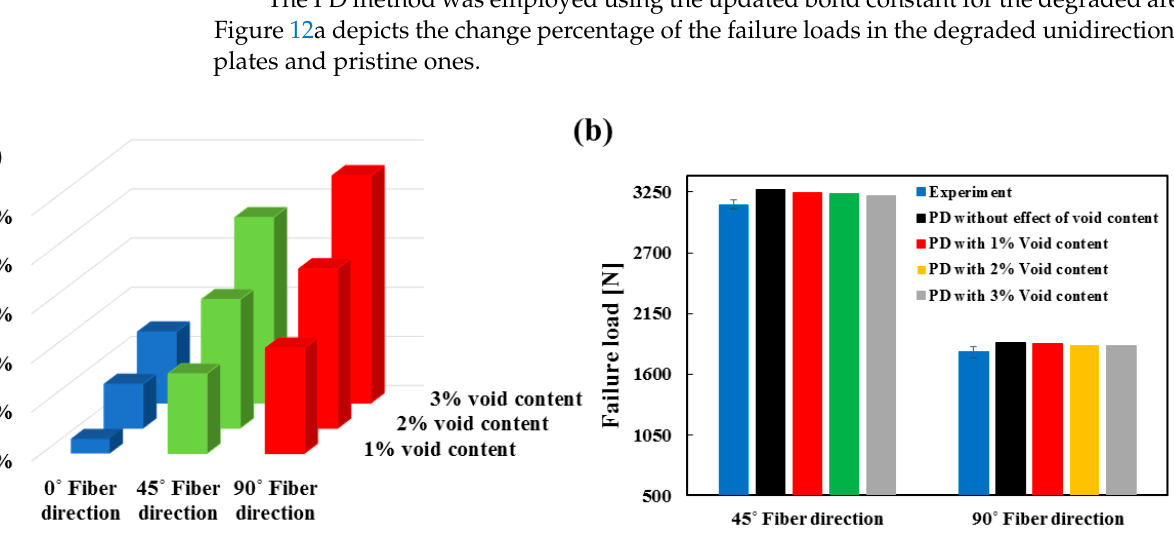
Figure 12. ( a ) Perturbation of failure loads of degraded unidirectional plates in comparison with pristine plates; ( b ) comparison of the strength of the unidirectional (UD) plate with one hole for different scenarios.